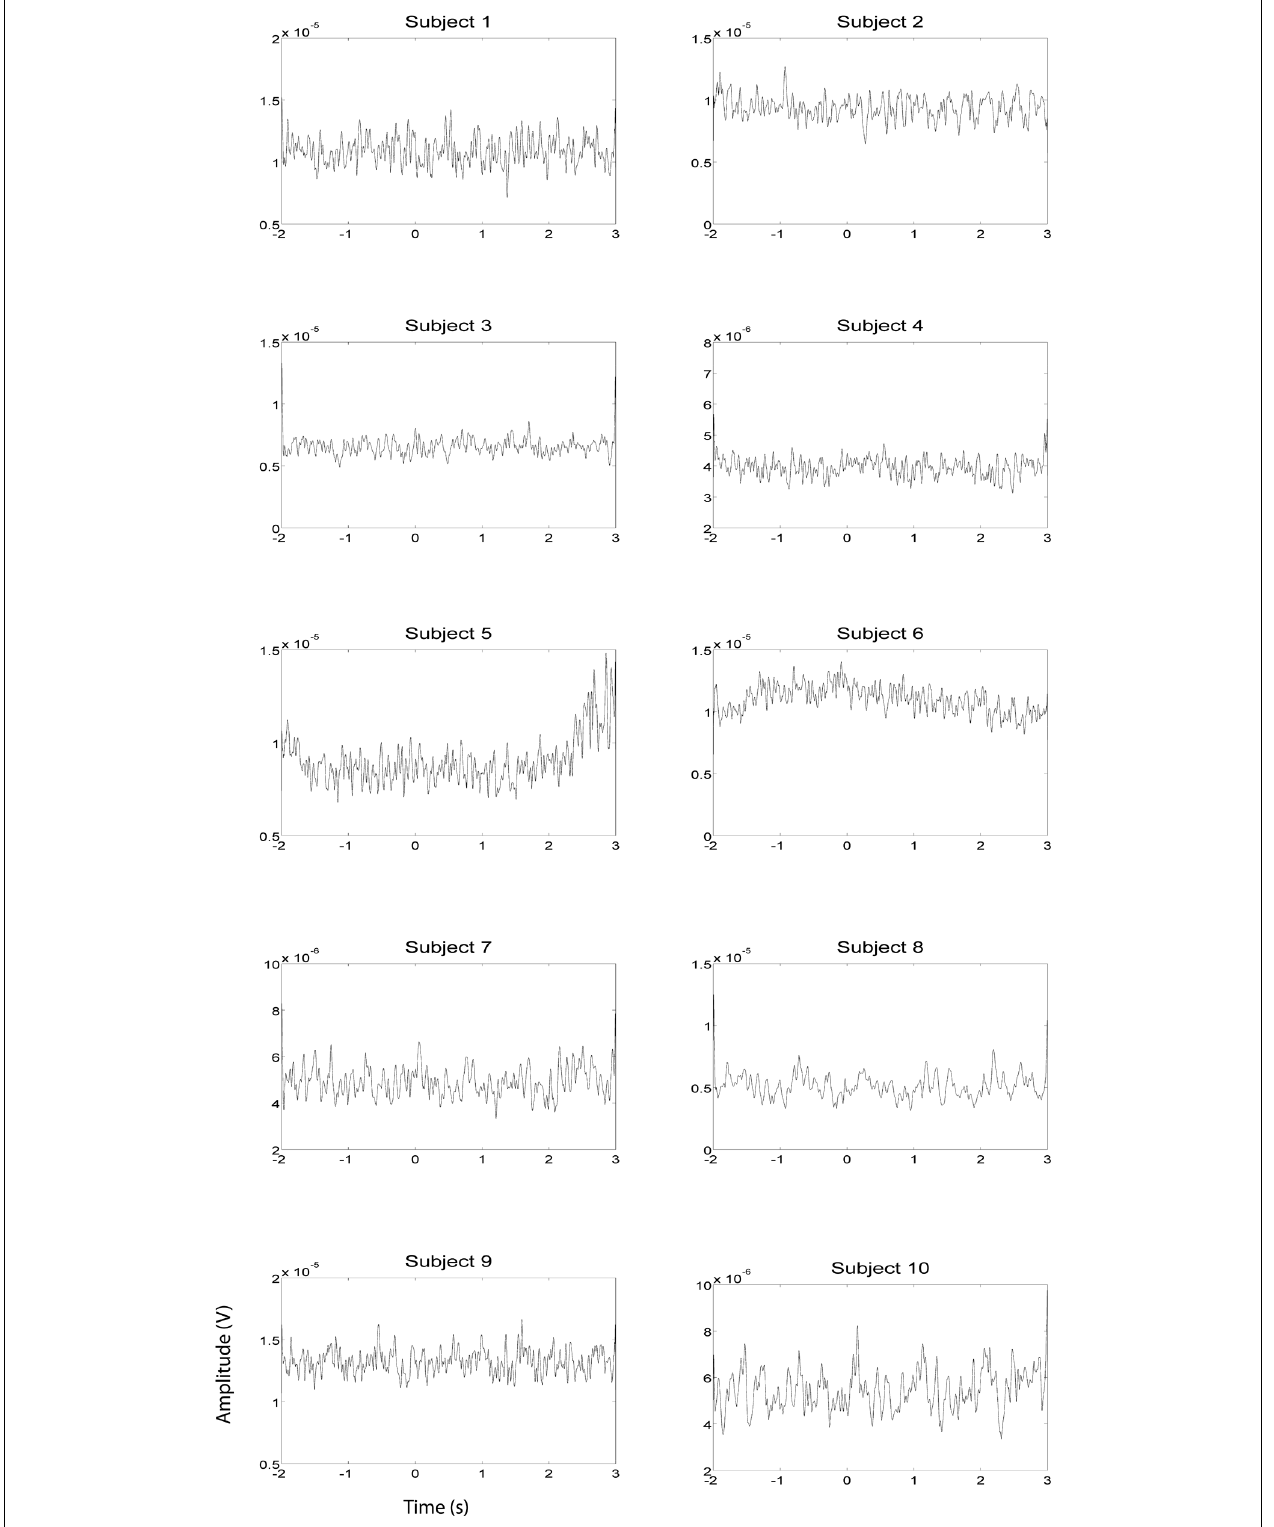
FIGURE 4 | EOG HG magnitude during left hand EEG motor imagery recording sessions ( n = 10). EOG activity was averaged over all trials that were not contaminated by artifacts. Units of the EOG are inV.